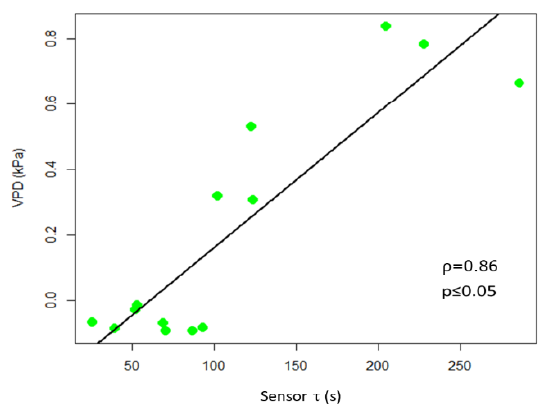
Figure 6. Scatter plot of τ and VPD. The scatter plot and linear regression indicate a high positive correlation between the two variables, with Pearson correlation coefficients ρ = 0.86, p ≤ 0.05.